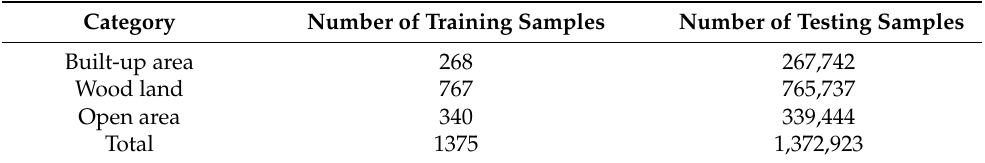
Table 6. The distribution of training samples in each category for the SVM in Oberpfaffenhofen image.